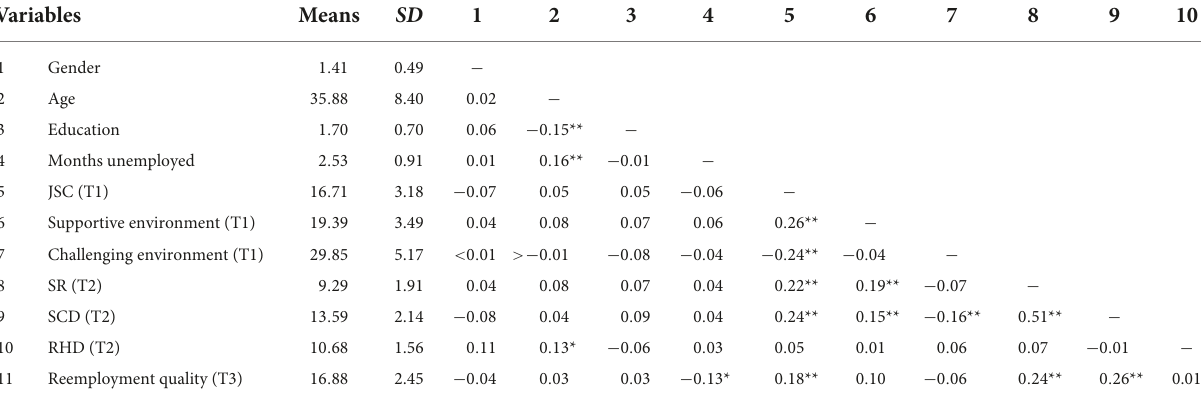
TABLE 2 Means, standard deviation, and correlations for variables.